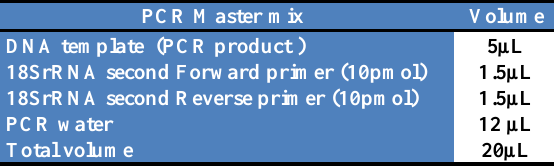
Table, 4: Company instructions of Secondary PCR master mix.